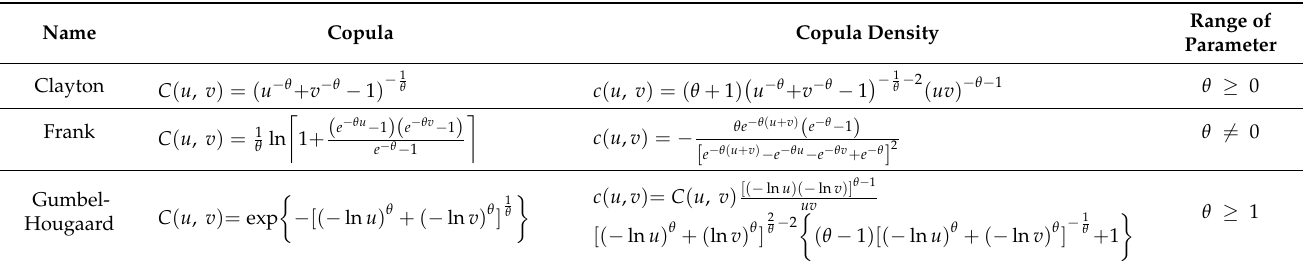
Table 1. Summaries of copulas and the corresponding copula densities and range of parameter used in this study. Name Copula Copula